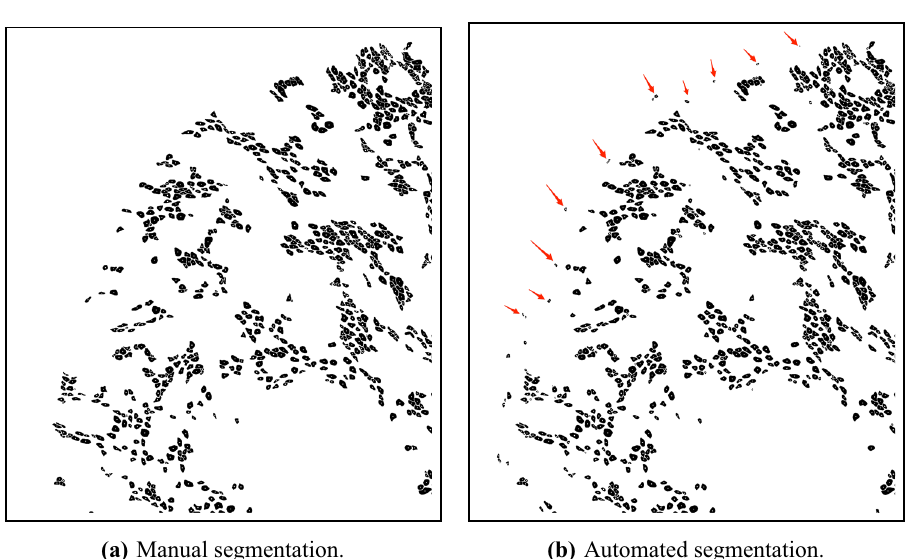
(a) Manual segmentation. (b) Automated segmentation. Figure 9. Example of axon segmentation in a cropped fragment of the test image 20. The red arrows point the spurious false positives identified at the edge of the vagus nerve. These objects located around the periphery of the region of interest affect the spatial second-order statistics of the